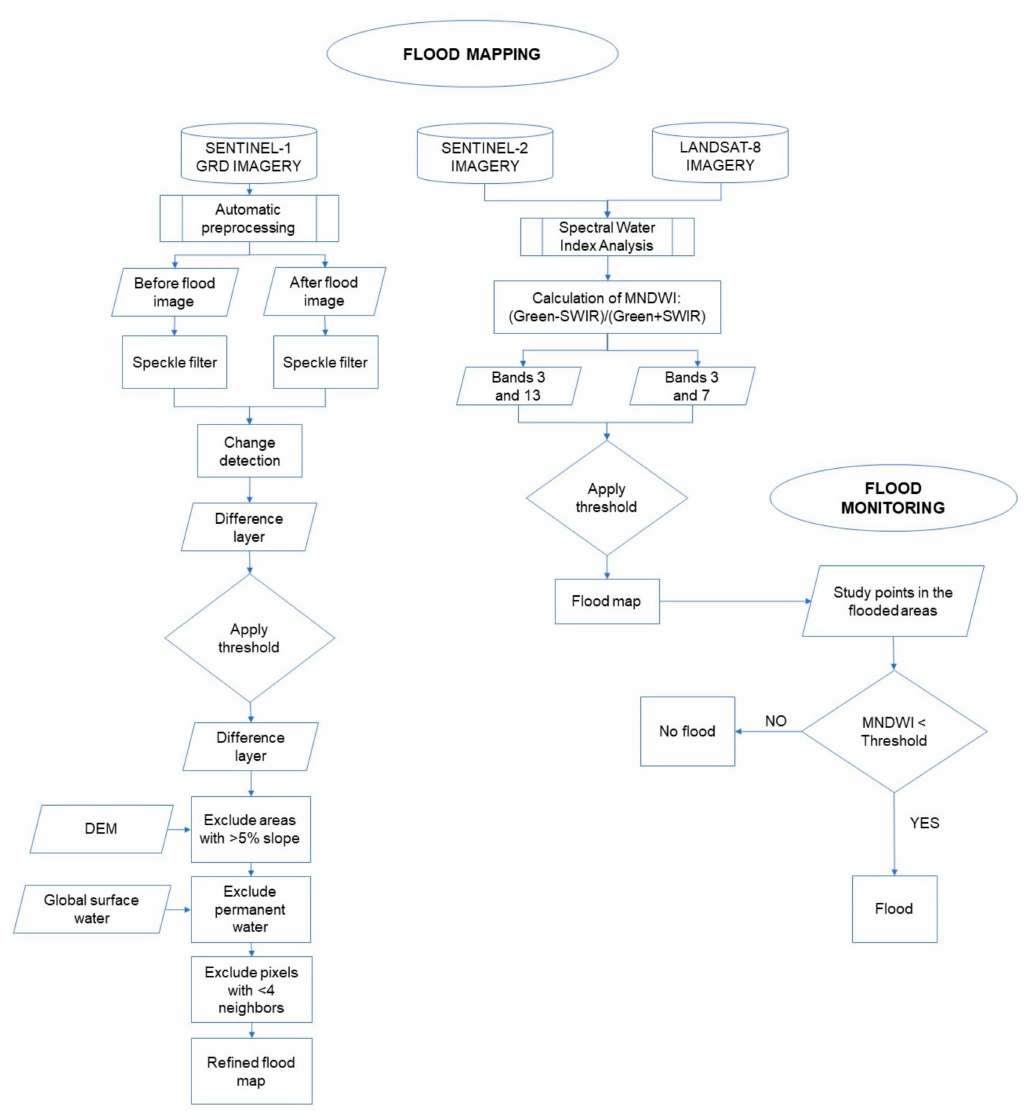
Figure 5. Flowchart for flood mapping and